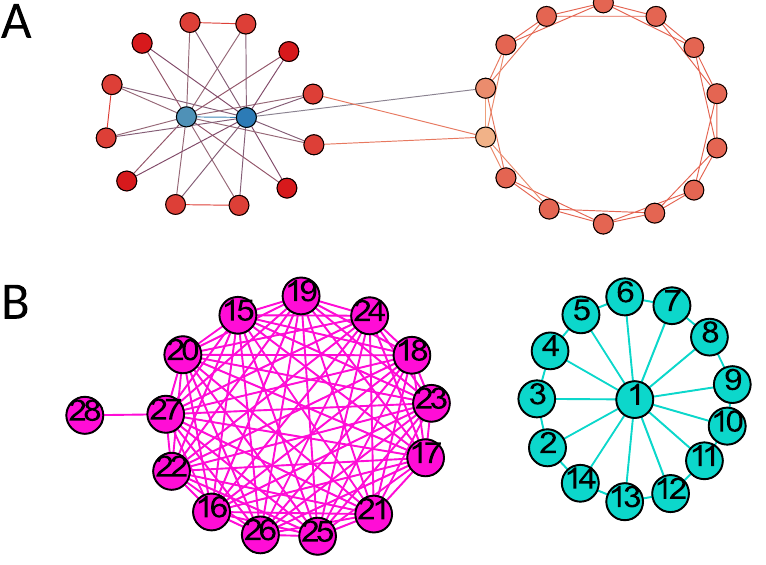
Figure 1. A network with both kinds of communities. ( A ) A leader community (left) and a self-organizing community that can be identified by the variance of node degree. The two communities have 14 nodes and an average node degree of 4. However, the degree variance of the leader community is 13.7 while the degree variance of the self-organizing community is 0. Here the degree of a node counters the edges within its community. ( B ) Another leader community (right) and a self-organizing community (left), each of which has 14 nodes. The leader community has an average node degree of 3.7 and a degree variance of 7.1. In contrast, the self-organizing community has a larger average node degree of 11.3 and a larger degree variance of 8.8. While the self-organizing community has a larger degree variance, it is not a leader community. Likewise, the leader community has a smaller degree variance than the self-organizing community, the former is a typical leader